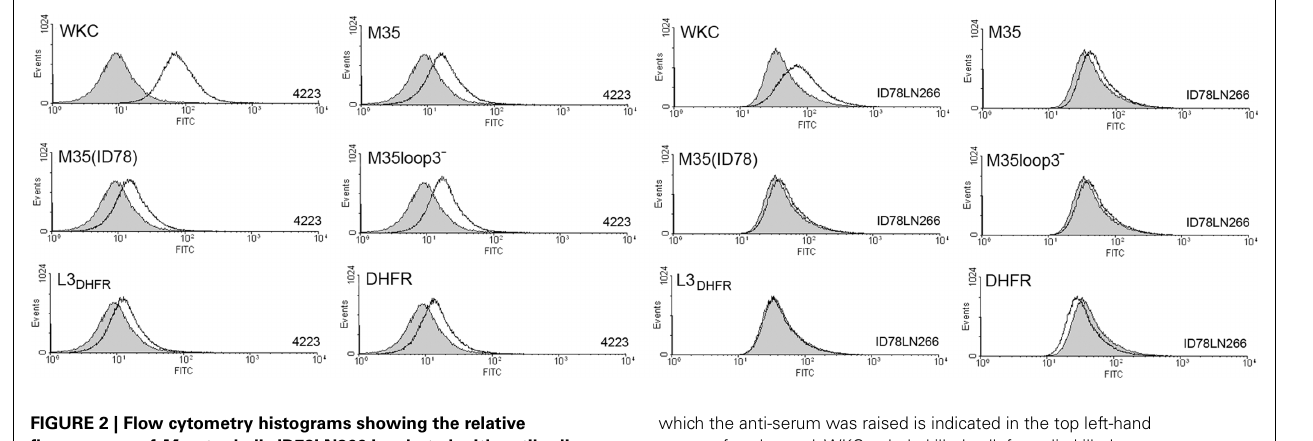
FIGURE 2 | Flow cytometry histograms showing the relative fluorescence of M. catarrhalis ID78LN266 incubated with antibodies raised against the M35-derived constructs .The strain is indicated in the lower right-hand corner of each panel and the antigen against